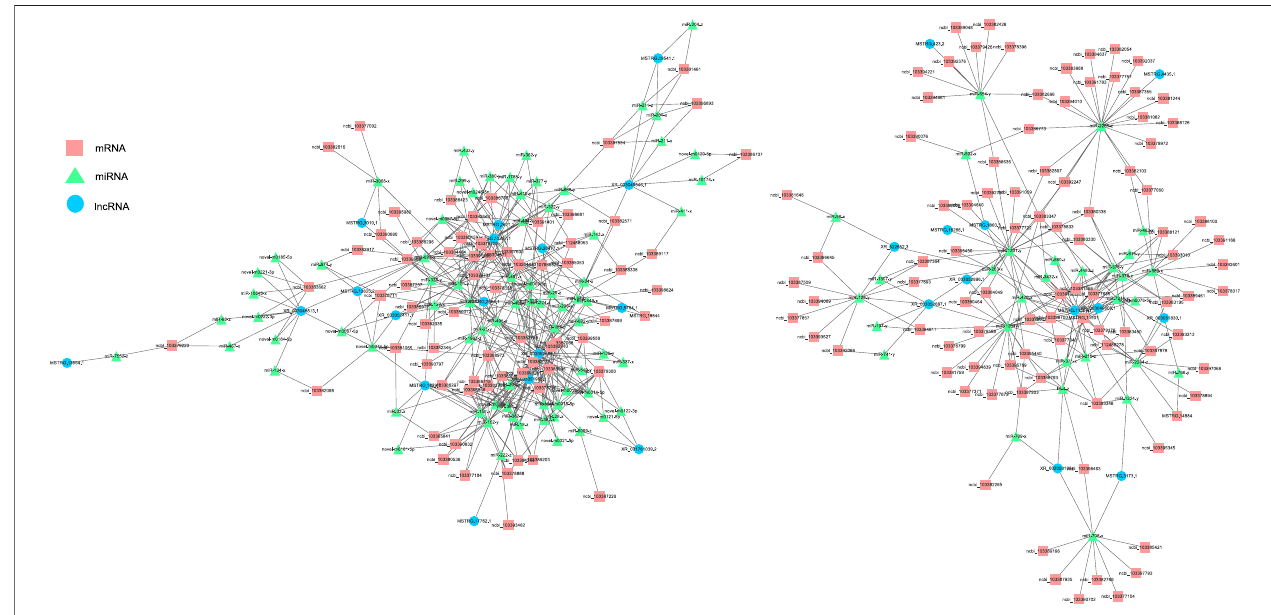
FIGURE 6 | Functional lncRNA – miRNA – mRNA regulatory modules between blind-side normal skin and blind-side hypermelanotic skin. lncRNAs, miRNAs, and mRNAs are represented by blue circles, green triangles, and pink squares,